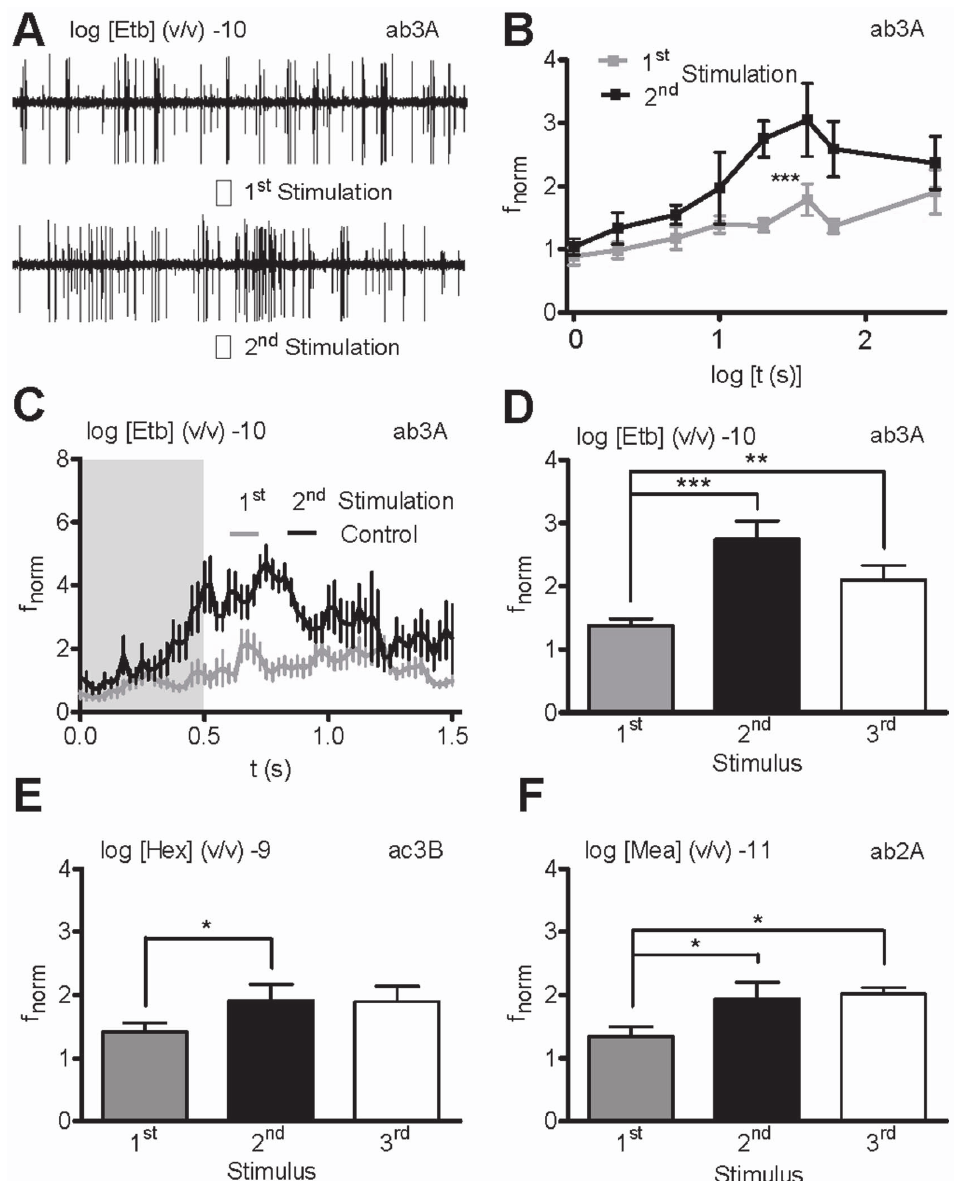
Figure 1. Repeated subthreshold stimulation sensitizes odorant receptors. A , Recordings of neuronal activity from ab3 sensilla (large action potentials, ab3A neuron expressing Or22a; small action potentials, ab3B neuron expressing Or85b) upon before and after 20 s repeated ethyl butyrate (Etb) stimulation ( 2 10 v/v; 0.5 s, shaded area). The first stimulation fails to elicit a response while the second does so. B , Dependence of normalized ab3A neuron spike frequency (f norm ) upon 1 st and 2 nd subthreshold Etb stimulation ( 2 10 v/v; 0.5 s) on the interval between stimulations ( n =12). C , Time course of f norm for 1 st and 2 nd stimulation (interval 20 s, n =12). D–F , Mean f norm for ab3A ( D ), ac3B ( E ) and ab2A ( F ) neuron to repetitive subthreshold Etb ( D ), ethyl acetate (Eta, E ) and methyl acetate (Mea, F ) stimulations (interval 20 s, n =12). * P , 0.05, ** P , 0.01, *** P , 0.001; Paired Wilcoxon Signed Ranks test.